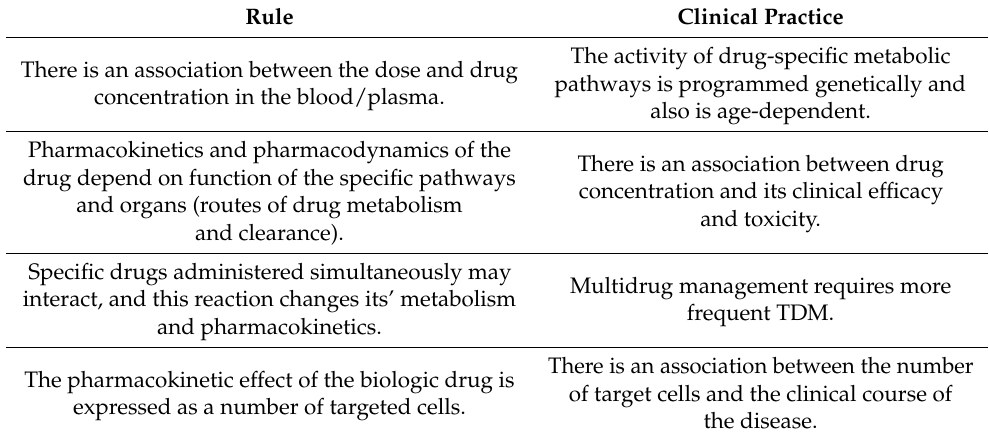
Table 3. Clinical background of TDM (therapeutic drug monitoring) and immunomonitoring